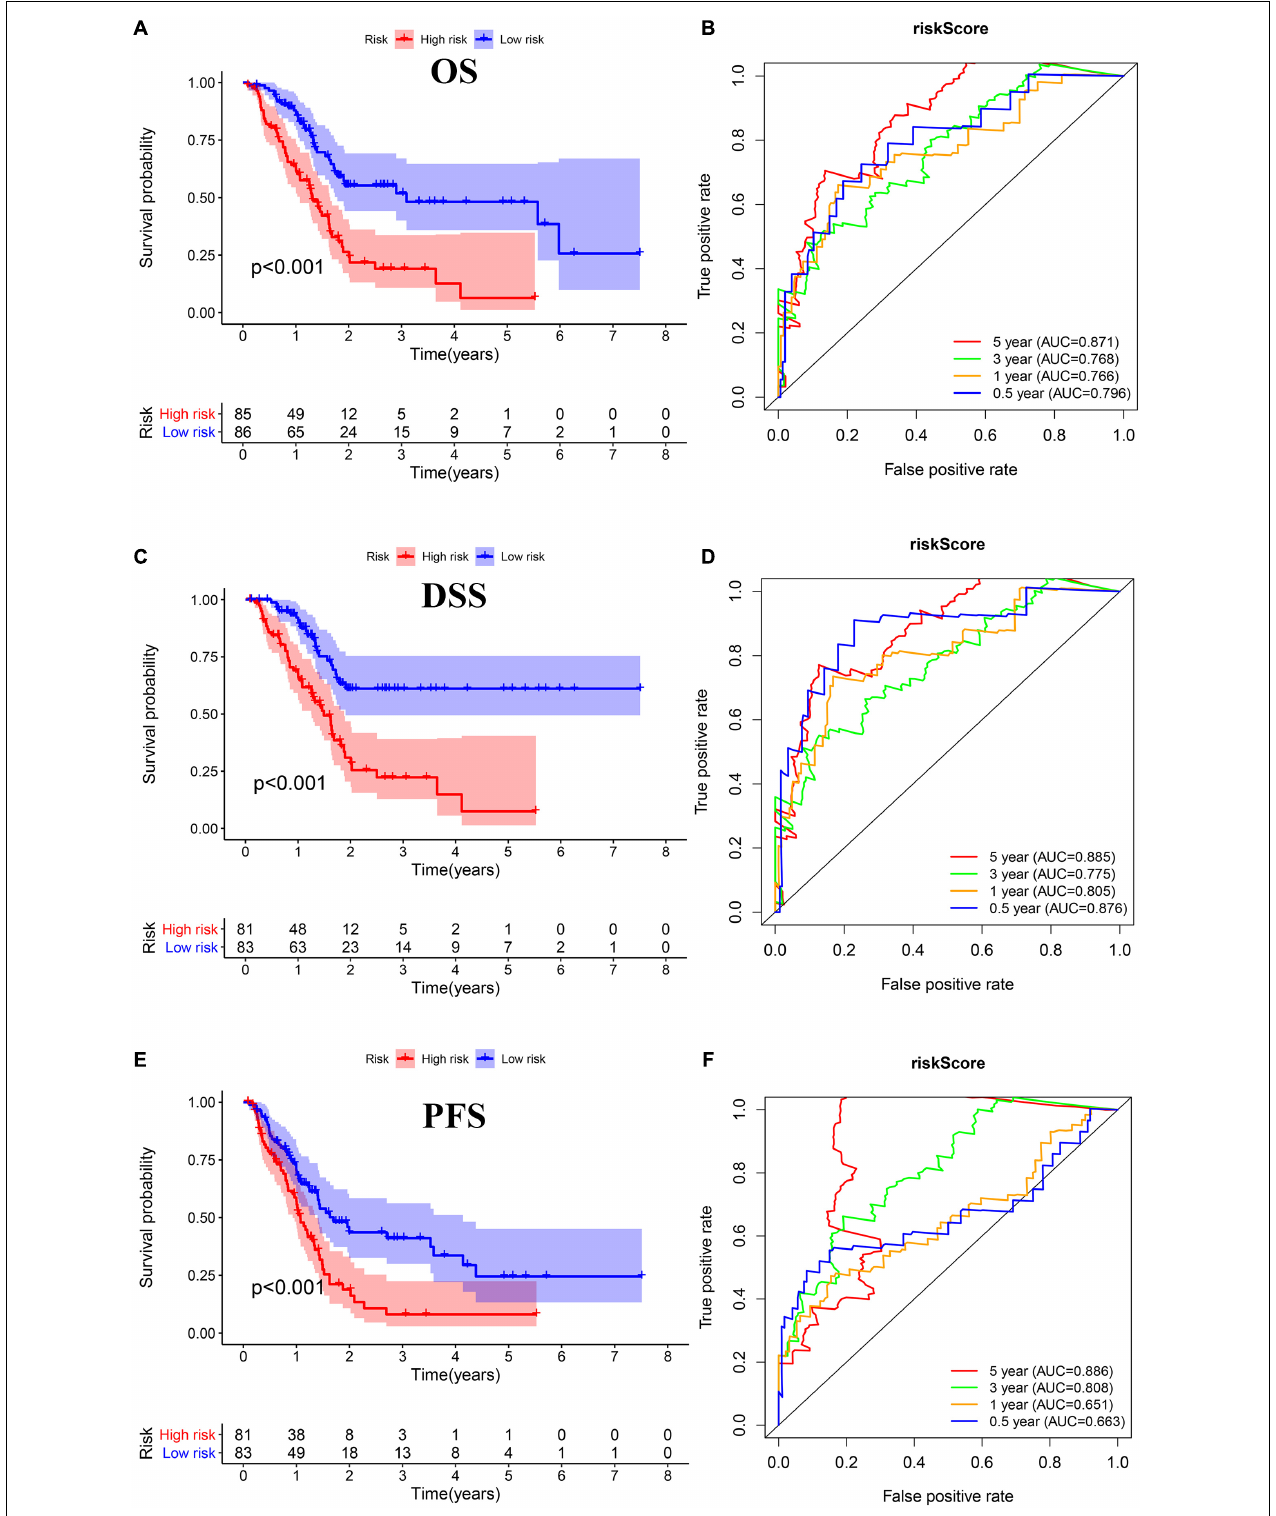
FIGURE 4 | Survival assessment of the prognostic model in TCGA cohort. (A,B) Kaplan–Meier survival analysis and time-dependent receiver operating characteristic (ROC) analysis of overall survival (OS). (C,D) Kaplan–Meier survival analysis and time-dependent ROC analysis of disease special survival (DSS). (E,F) Kaplan–Meier survival analysis and time-dependent ROC analysis of progression-free survival